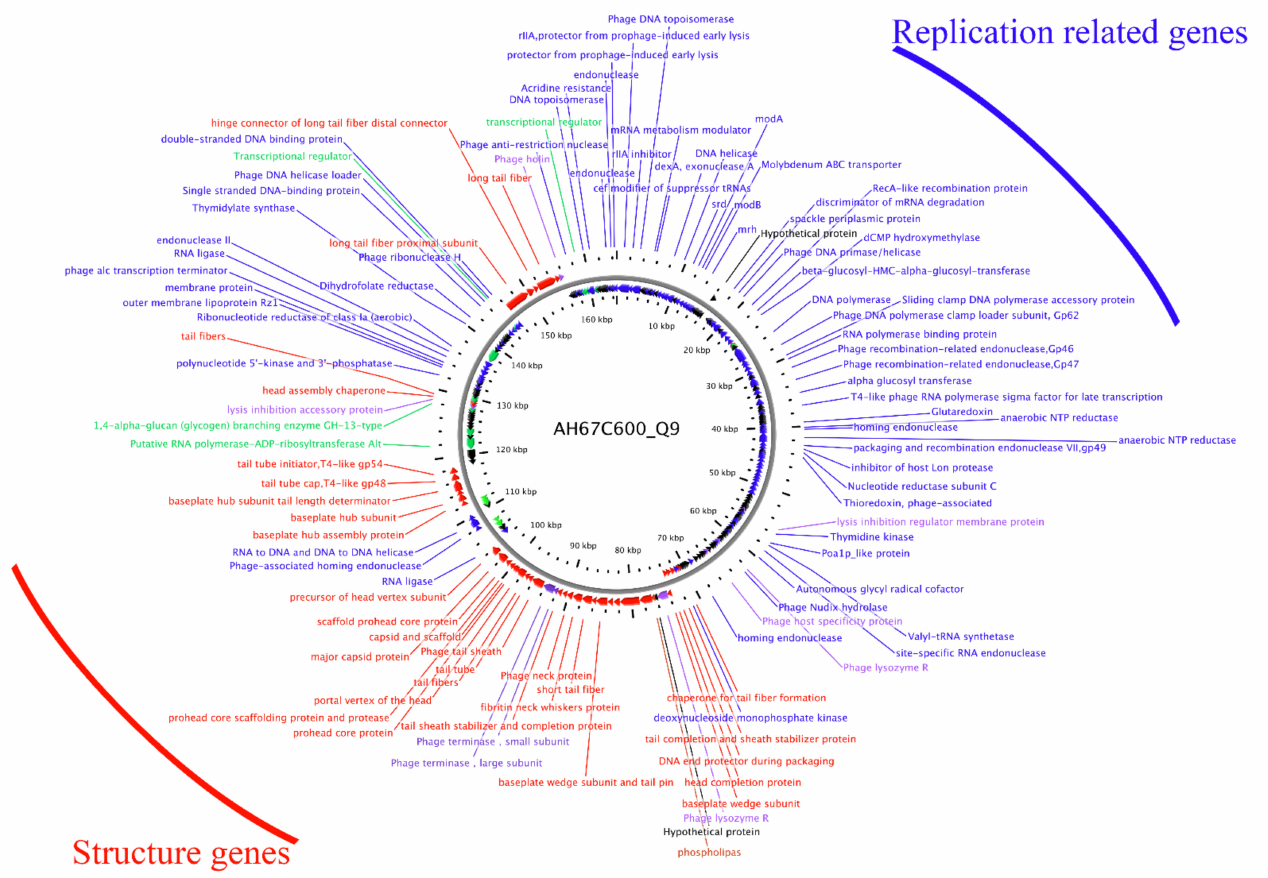
Figure 4. Annotation of the predicted genes of phage AH67C600_Q9. The genes located at upper right are replication-related and the structural genes are concentrated in the lower left corner. Blue, replication related genes; red, structure genes; purple, lytic related; green, transcription related; black, hypothetical